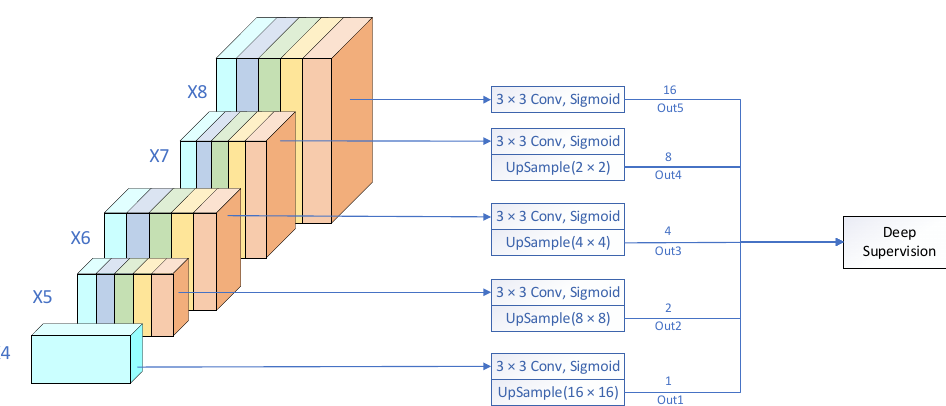
Figure 7. Schematic diagram of deep supervision (the weights of ×4, ×5, ×6, ×7, and ×8 are 1, 2, 4, 8, and 16 in order).